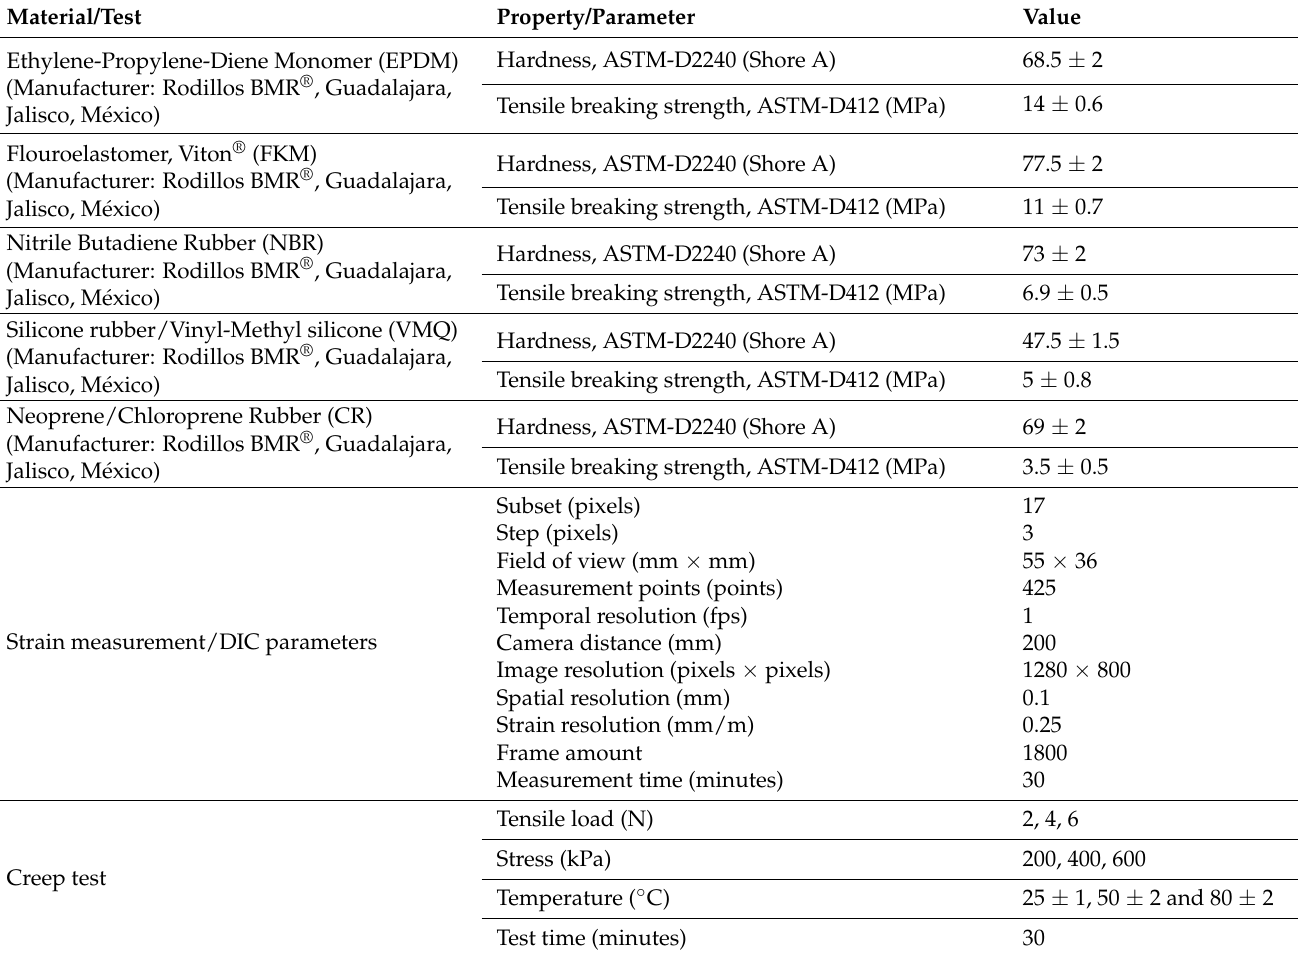
Table 1. Material properties and parameters of creep test and DIC